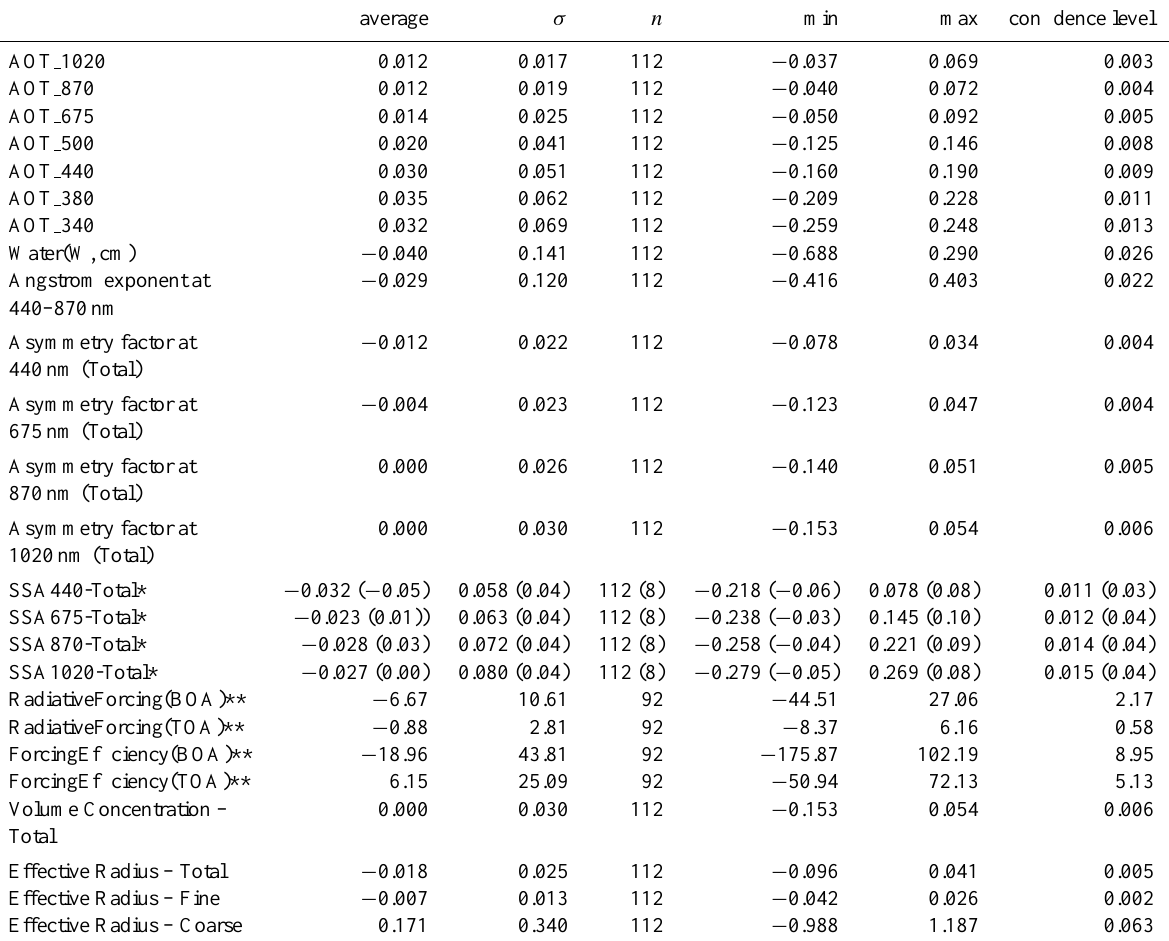
Table 2. Main statistics for the mean differences in aerosol and radiative characteristics between Moscow and Zvenigorod. Dataset 2.